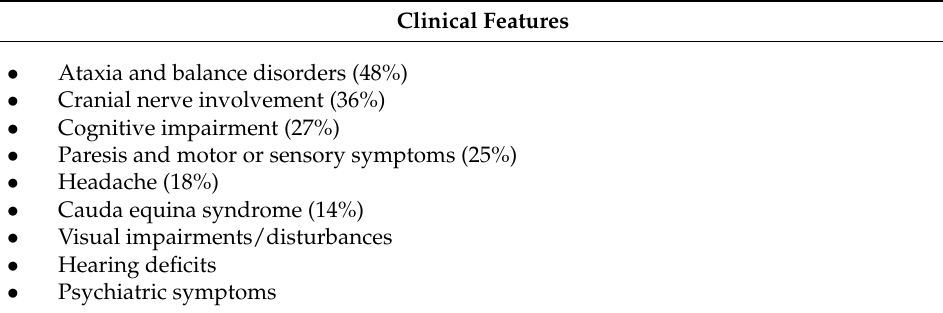
Table 1. Clinical features of Bing–Neel syndrome.